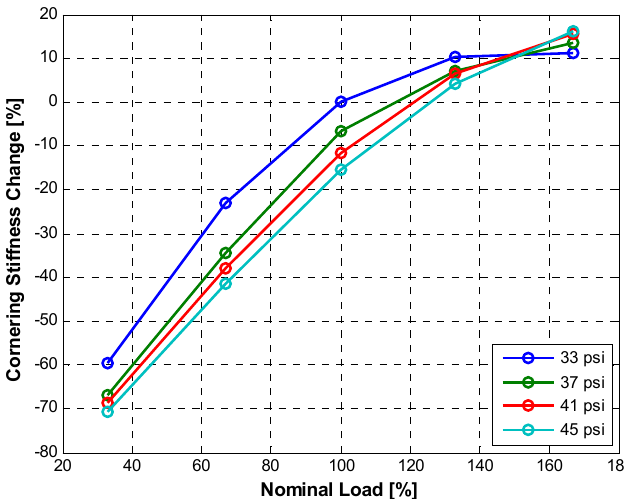
Figure 9. Influence of inflation pressure on the tire cornering stiffness.